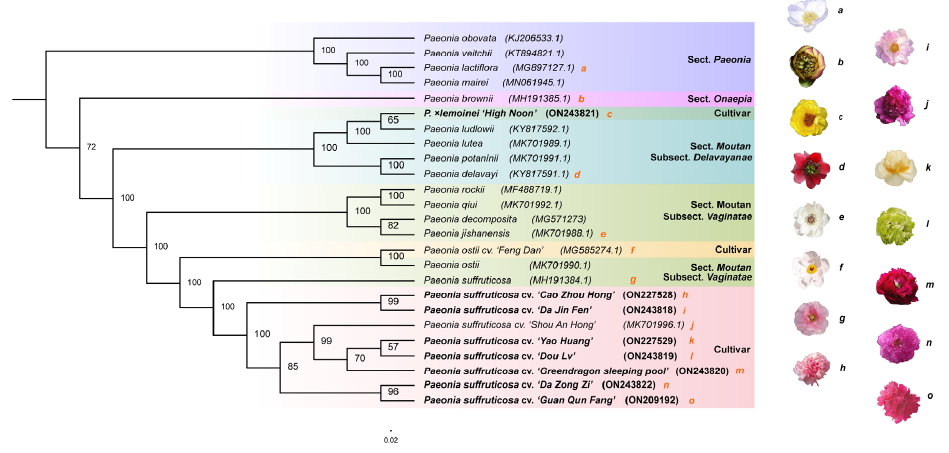
3333333333 Figure 3. Phylogenetic tree constructed using the maximum likelihood (ML) method based on the complete chloroplast genome sequences of 15 Paeoniaceae species and 10 tree peony flower